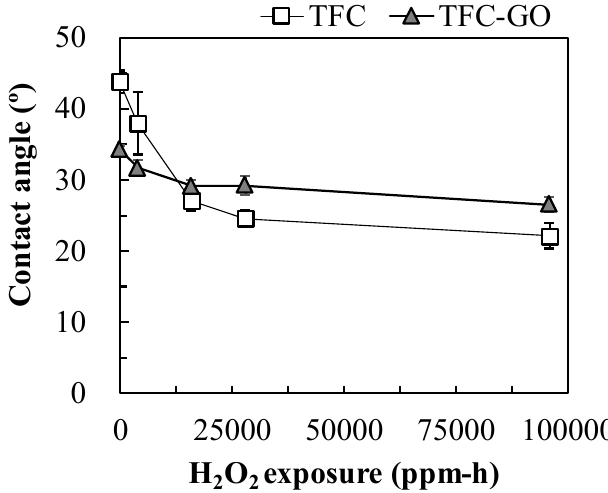
Figure 4. Contact angle of TFC and TFC-GO membranes with the range of 0 − 28,000 ppm-h H 2 O 2 exposure. Error bars represent one standard deviation of triplicate measurements.